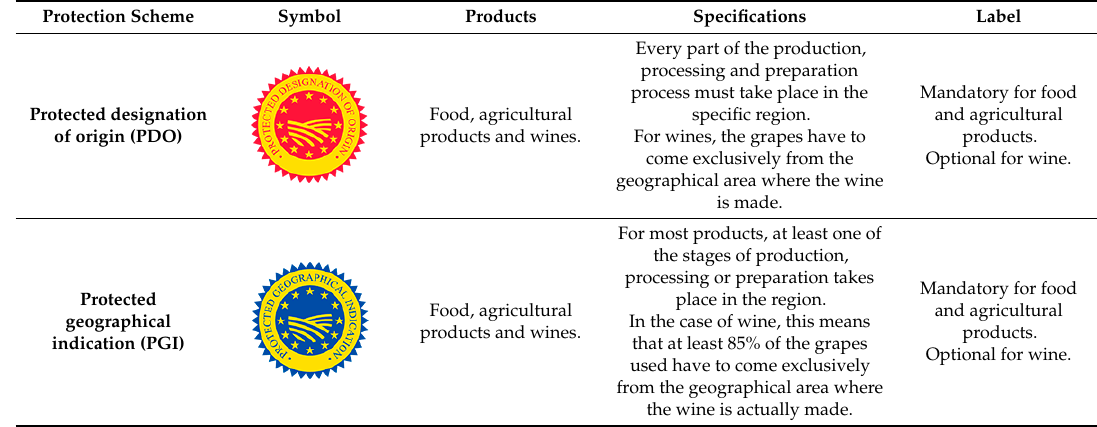
Table 1. European Union labels for protected traditional products [46].